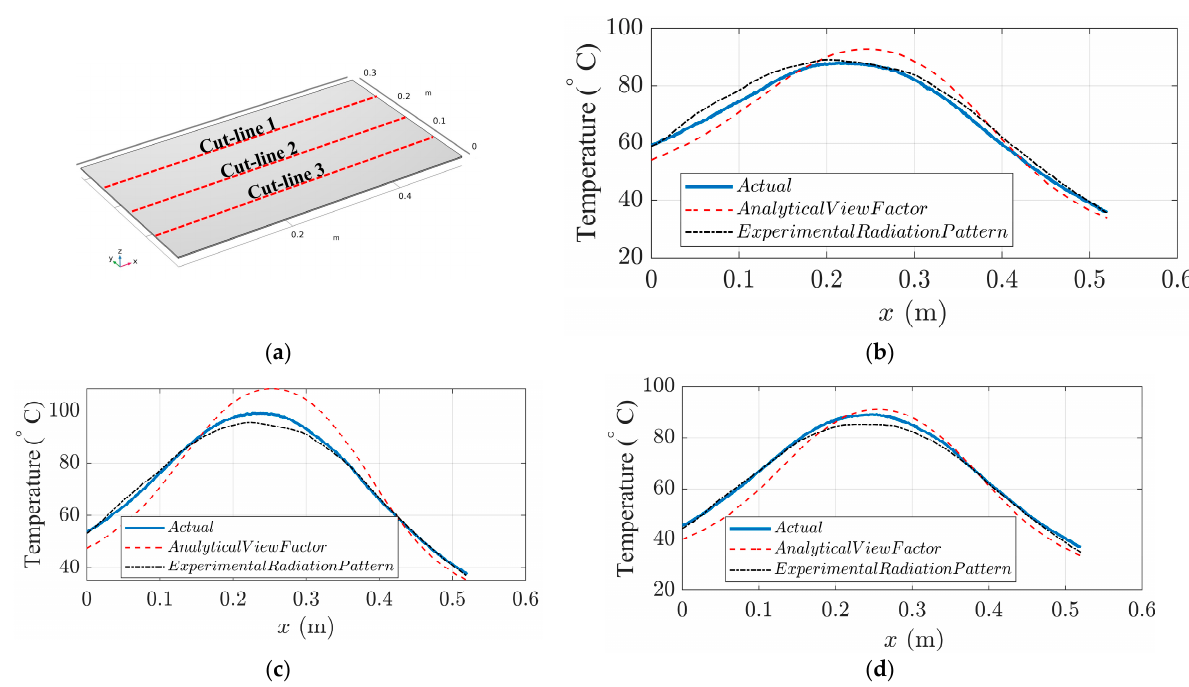
Figure 14. Actual and simulated temperature variations along three cut-line in the x direction of the thermoplastic sheet, ( a ) cut-line locations; ( b ) cut-line 1 temperatures; ( c ) cut-line 2 temperatures; ( d ) cut-line 3